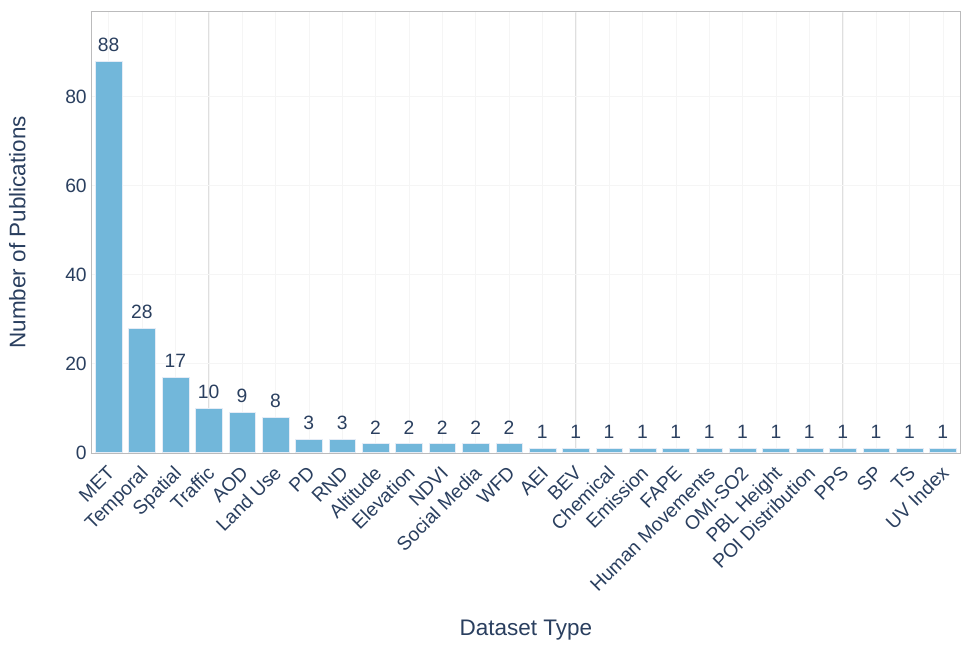
Figure 2. The number of publications per each dataset type.